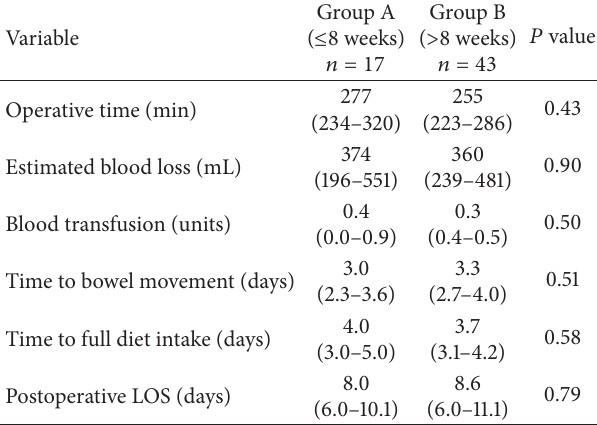
Table 3: Perioperative results.